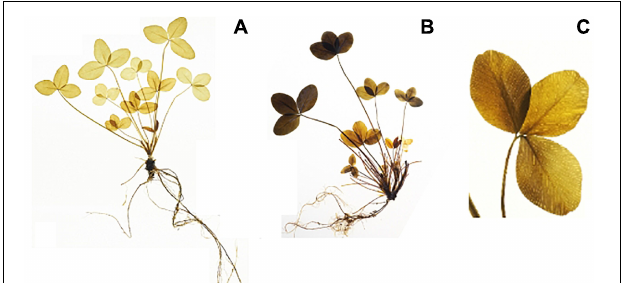
FIGURE 3 | Iodine stained red clover plants (clones from the same genotype) visualizing starch distribution (dark coloration). There are clear differences in starch accumulation between harvest times (A) the end of the night (EN), (B) the end of the day (ED). Differences in starch accumulation are also visible within one plant (B) , and within one leaf (C) .